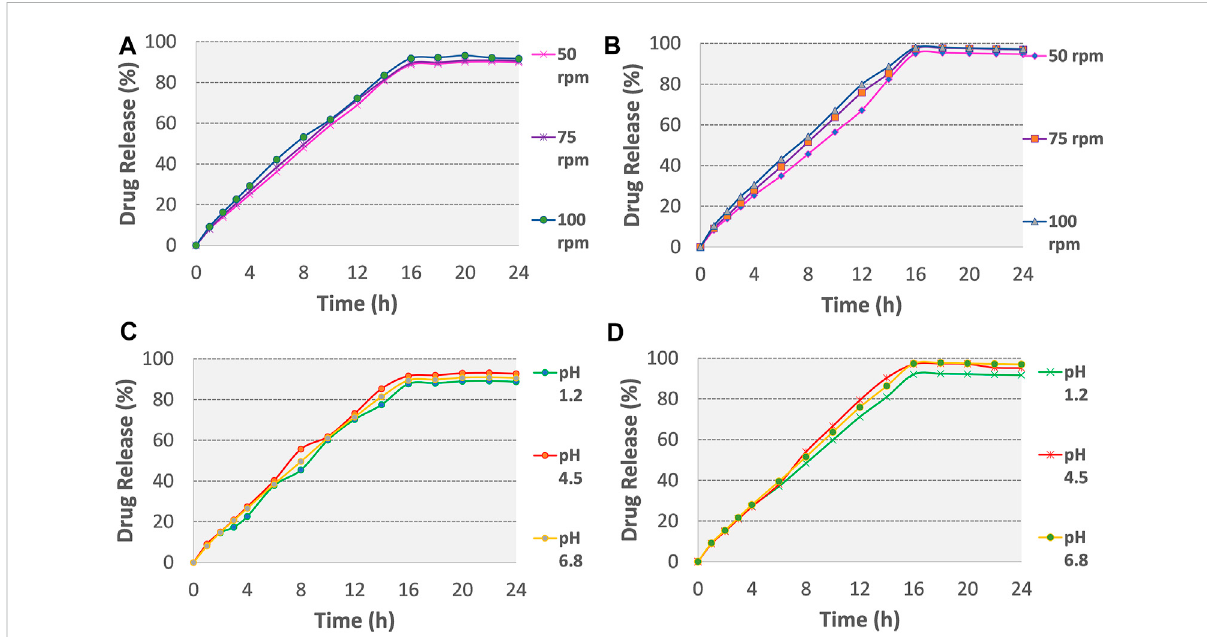
FIGURE 5 Release plots of tramadol HCl from formulation (A) F3 and (B) F4 in dissolution media 0.1 M HCl (pH 1.2) for 2 h and then in phosphate buffer (pH6.8)from3 – 24 hatvariablestirringrates(50,75,100 rpm).ReleaseplotsoftramadolHClfromformulation (C) F3and (D) F4invariousdissolution media with different pH values (pH 1.2, 4.5, 6.8; stirring rate 75 rpm).